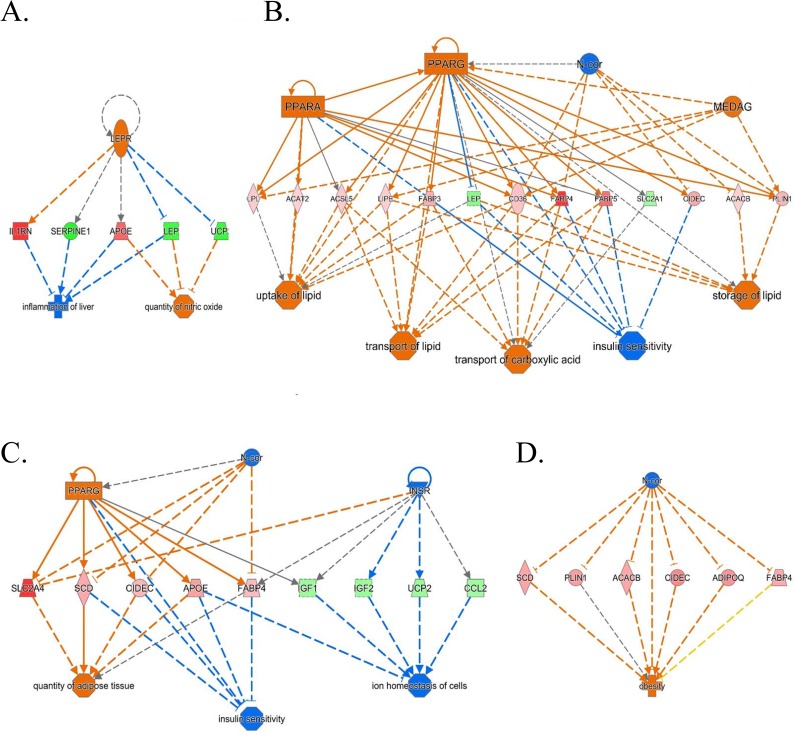
Regulatory network analysis using IPA.Regulatory network generated in IPA for genes that were differentially expressed following exposure to BPA (A, B) and BPS (C, D) on day 2 and day 4. Orange represents activated upstream regulator or biological process; Blue represents inhibited upstream regulator or biological process; Red indicates gene expression is up-regulated; Green indicates gene expression is down-regulated.